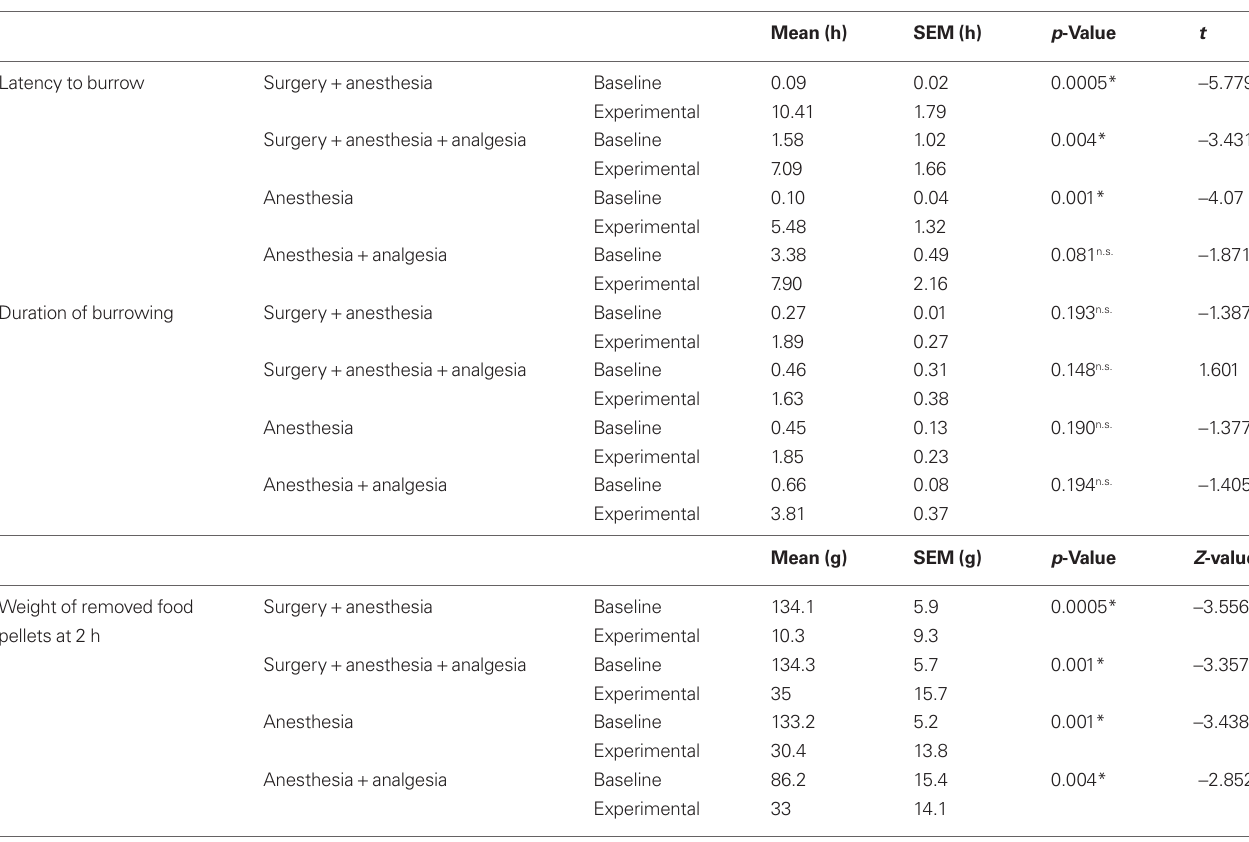
Table 1 | Absolute values of latency to burrow, duration of burrowing and weight of removed food pellets. Results of paired t -test for latency to burrow and duration of burrowing, and Wilcoxon test for removed pellet